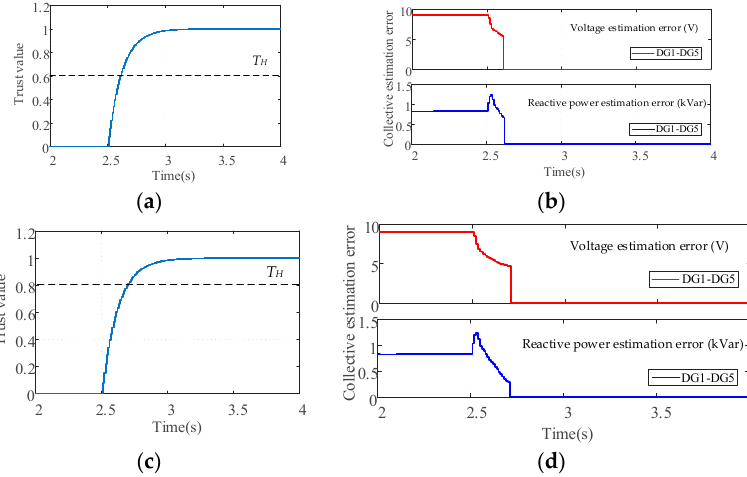
Figure 13. The impacts of rejoining threshold T H on the collective estimation error: ( a ) DG1’s common trust value under T H = 0.6; ( b ) Collective estimation error of all DGs under T H = 0.6; ( c ) DG1’s common trust value under T H = 0.8; ( d ) Collective estimation error of all DGs under T H =